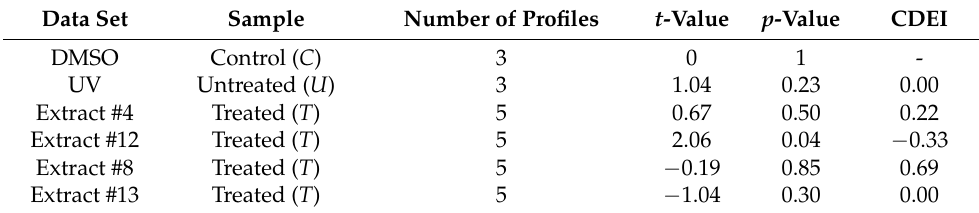
Table 3. CDEI testing results—EpiDermFT.